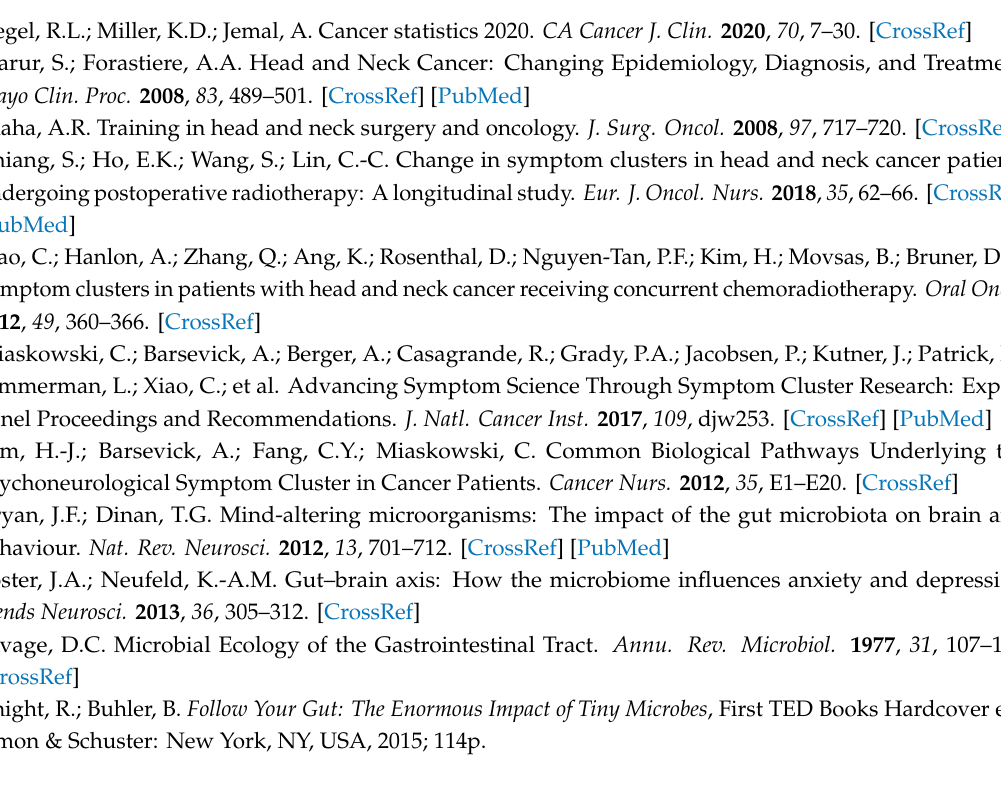
Table S1: Functional Pathway Analysis of the Gut Microbiome based on PNS